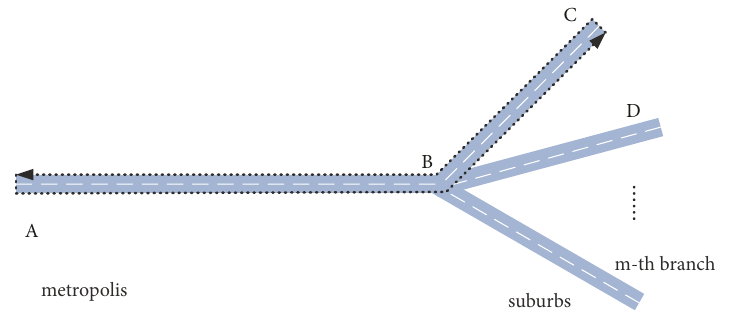
Figure 2: A trunk-and-branches public transport network connecting metropolis and suburbs. The dotted line with arrows shows the operational strategy for one round trip traversed by one of the bus lines. The same strategy applies to all 𝑚 bus lines in the transit